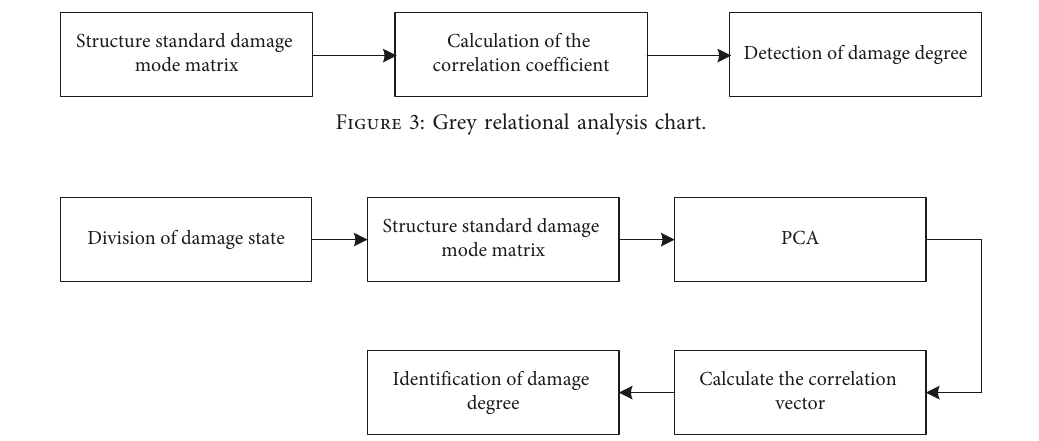
Figure 4: Damage degree detection chart. Table 5: Main parameters of the